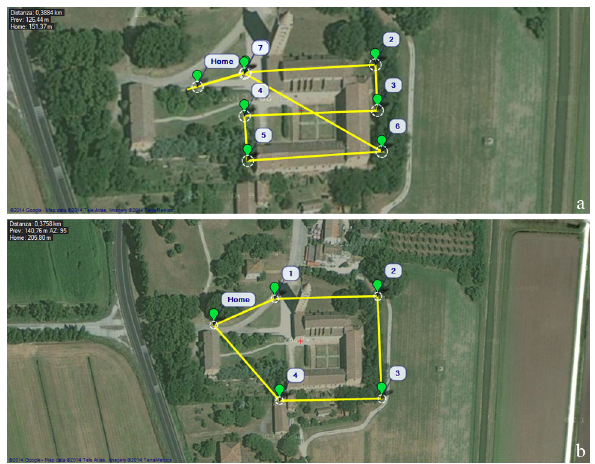
Figure 7. Two UAV flight plans: a) nadiral acquisitions; b) camera sloped acquisitions.